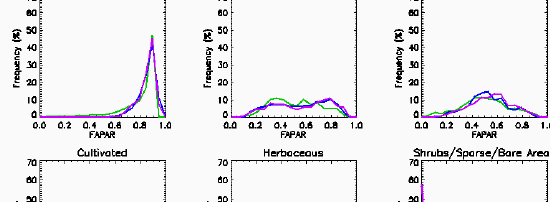
Figure 3: Distribution of differences between PROBA-V and SPOT/VGT GEOV1 (Top) and between PROBA-V GEOV1 and MODIS C5 (Bottom) for LAI (Left side) and FAPAR (right side) products. Figure 5: Distribution of FAPAR values of each product for the BELMANIP2.1 sites during Nov13-May14 period for each biome